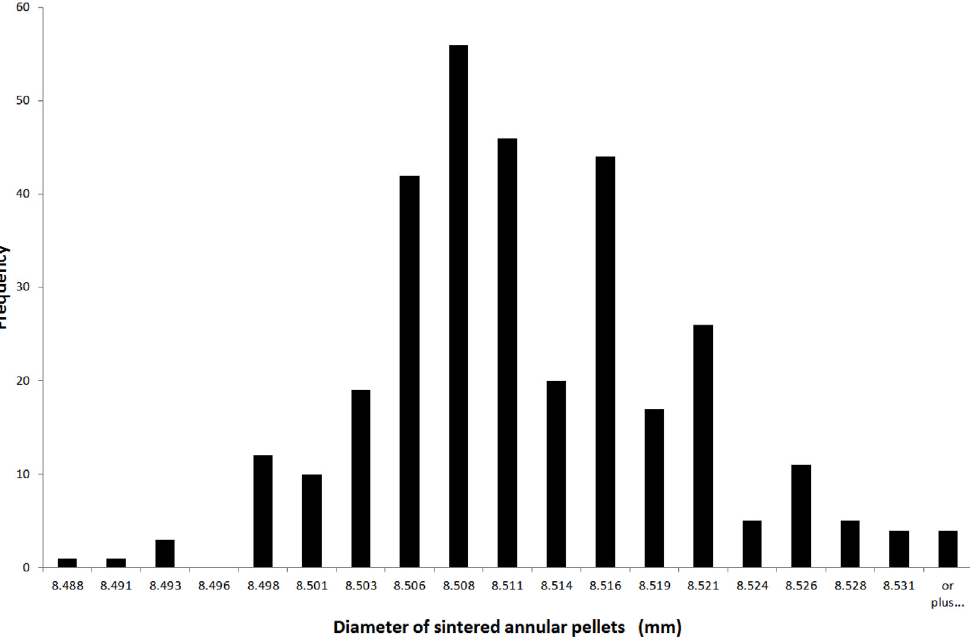
Fig. 4. Histogram of the sintered pellet diameter.